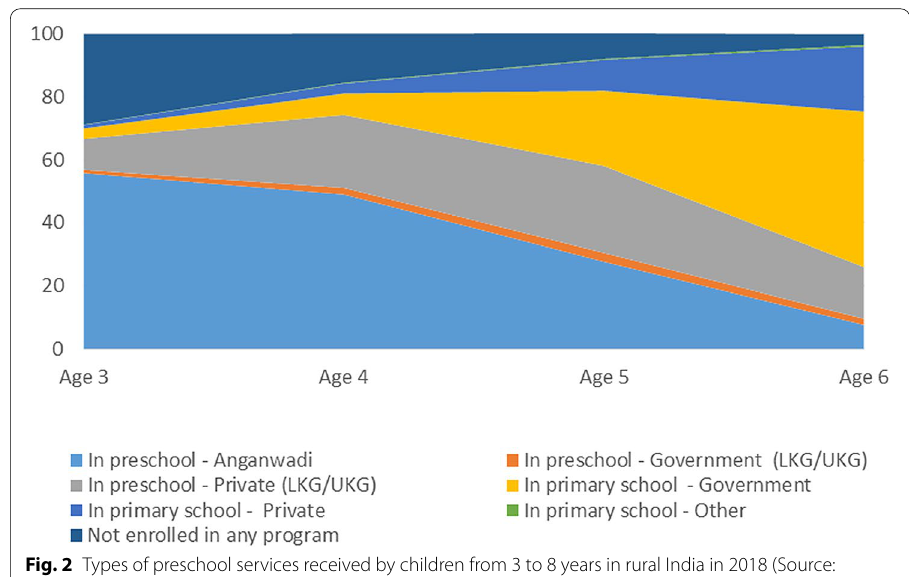
Fig. 2 Types of preschool services received by children from 3 to 8 years in rural India in 2018 (Source: ASER